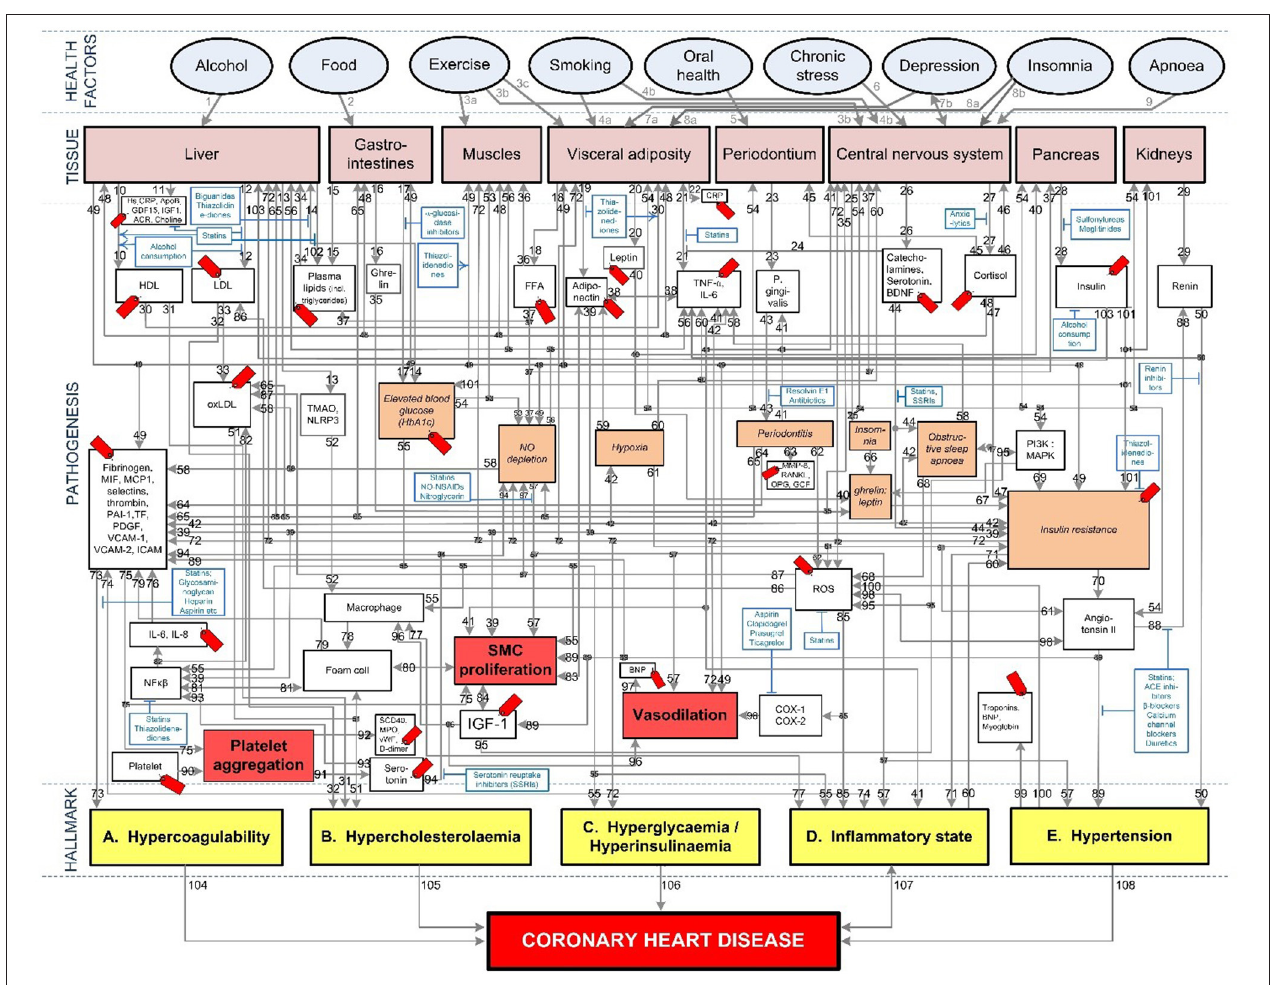
FIGURE 1 | Existing model showing the mechanisms of coronary heart disease (23–28). The affective pathway of pharmaceuticals, blue boxes, is shown in Figure and salient serological biomarkers are indicated by the red tags ( ). The blunted blue arrows denote antagonize or inhibit and pointed blue arrows denote up-regulate or facilitate. ACE, angiotensin-converting-enzyme; β -blocker, beta-adrenergic antagonists; BDNF, brain-derived neurotrophic factor; BNP, B-type natriuretic peptide; OX, cyclooxygenase; CRP, C-reactive protein; D-dimer, fibrin degradation product D; FFA, free fatty acids; GCF, gingival crevicular fluid; HbA1c, glycated hemoglobin A1c; HDL, high-density lipoprotein; Hs, homocysteine; ICAM, intracellular adhesion molecule; IGF-1, insulin-like growth factor-1; IL, interleukin; LDL, low-density lipoprotein; MAPK, mitogen-activated protein (MAP) kinase; MCP, monocyte chemoattractant protein; MIF, macrophage migration inhibitory factor; MMP, matrix metalloproteinase; MPO, myeloperoxidase; NF κβ , nuclear factor- κβ ; NLRP3, Inflammasome responsible for activation of inflammatory processes as well as epithelial cell regeneration and microflora; NO, nitric oxide; NO-NSAIDs, combinational NO-non-steroidal anti-inflammatory drug; OPG, osteoprotegerin; oxLDL, oxidized LDL; PAI, plasminogen activator inhibitor; PDGF, platelet-derived growth factor; P. gingivalis, Porphyromonas gingivalis; PI3K, phosphatidylinositol 3-kinase; RANKL, receptor activator of nuclear factor kappa-beta ligand; ROS, reactive oxygen species; SCD-40, recombinant human sCD40 ligand; SMC, smooth muscle cell; SSRI, serotonin reuptake inhibitors; TF, tissue factor; TMAO, an oxidation product of trimethylamine (TMA); TNF- α , tumor necrosis factor- α ; VCAM, vascular cell adhesion molecule; vWF, von Willebrand